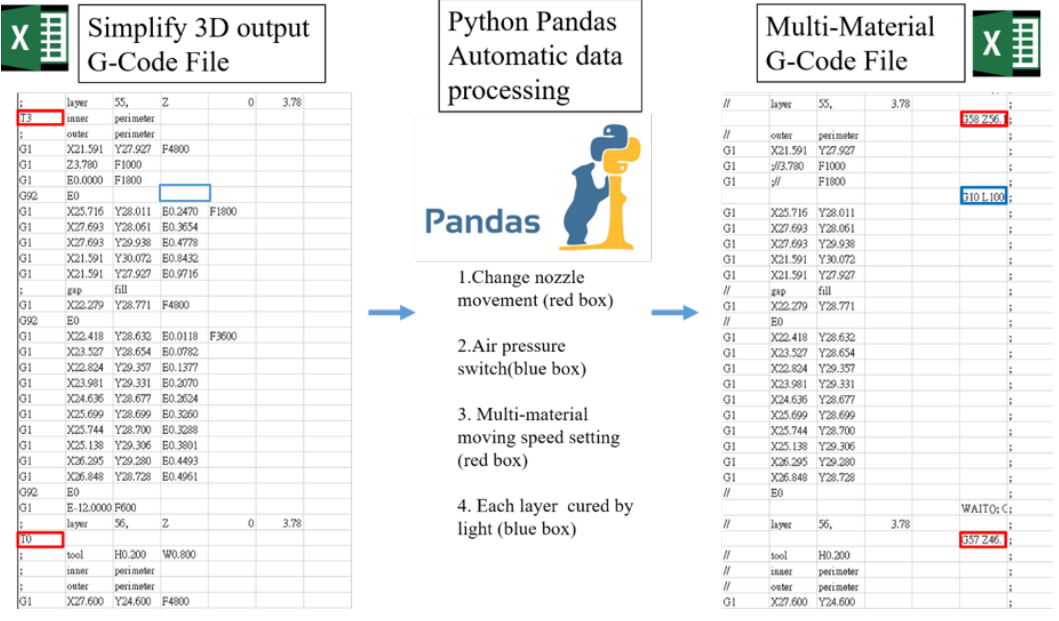
Figure 7. Post-processing flowchart by Python Pandas.